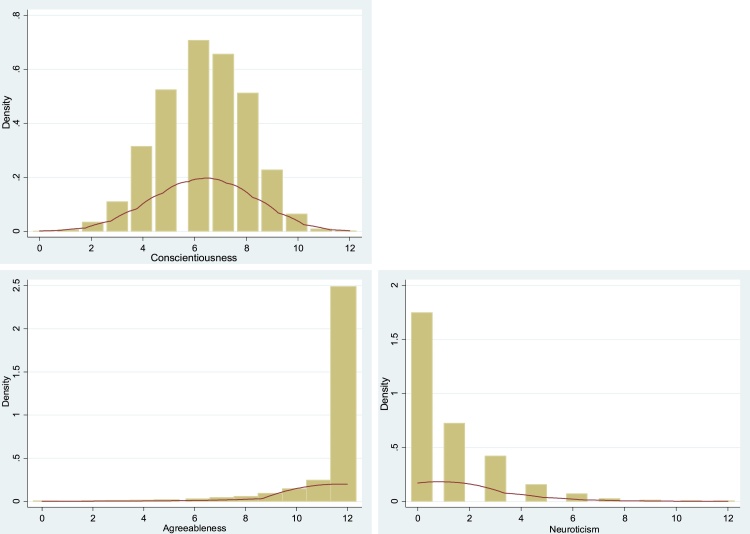
Distributions of teacher-reported conscientiousness, agreeableness, and neuroticism at age 16.